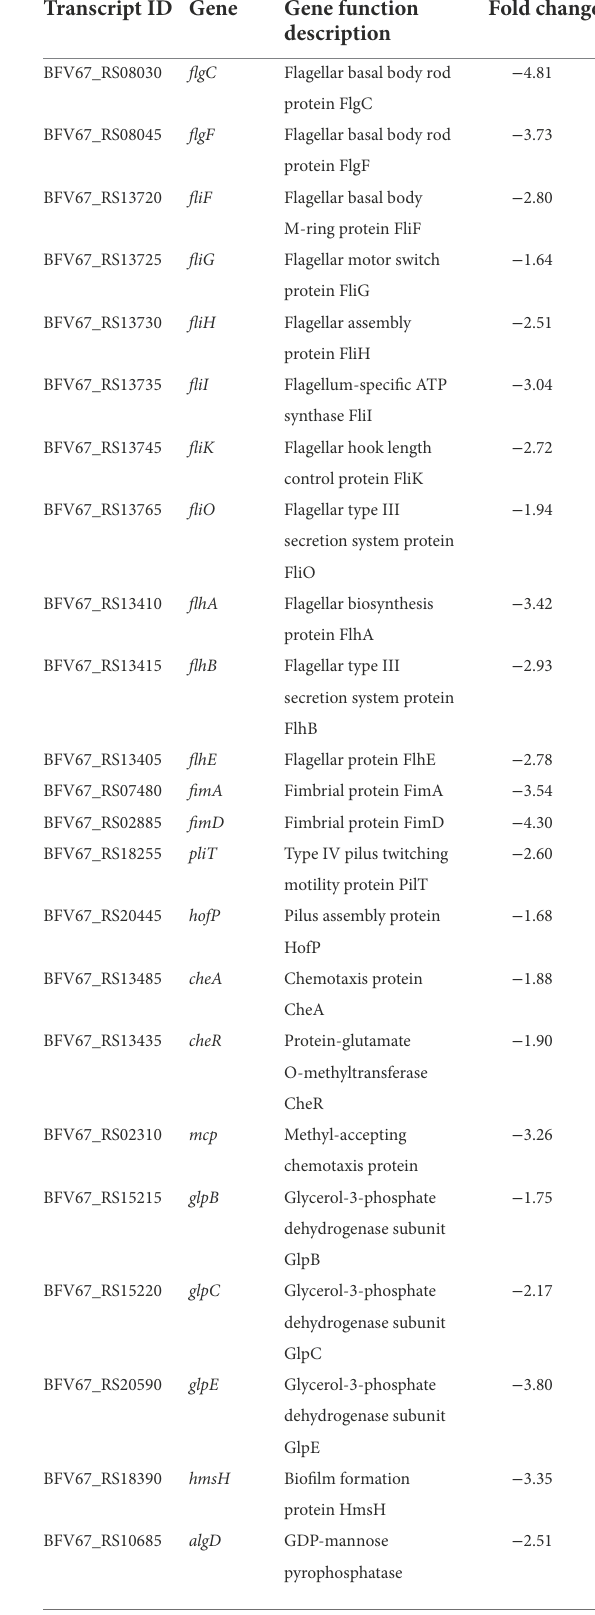
TABLE 2 The genes regulate by rpoS in Enterobactor cloacae